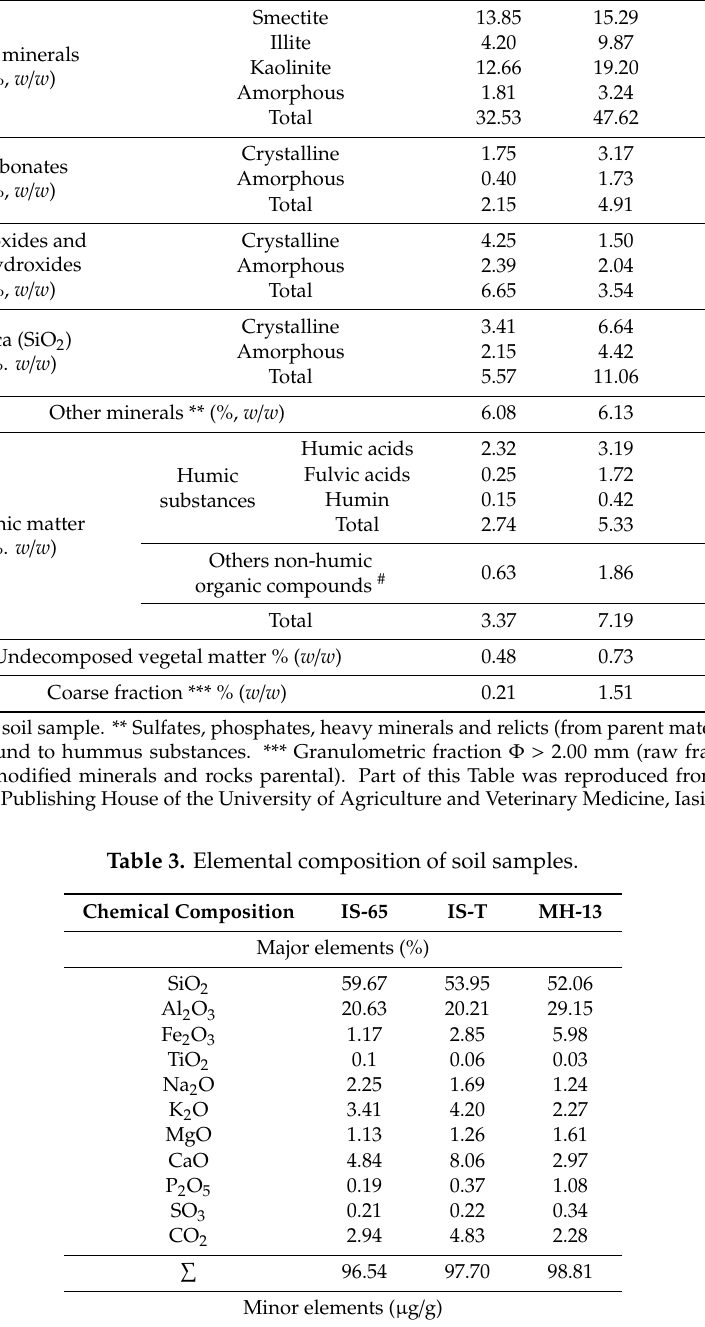
Table 2. Chemical–mineralogical composition of soil samples (% w / w ) * [33,34]. Chemical–Mineralogical Composition Clay minerals (%, w / w )